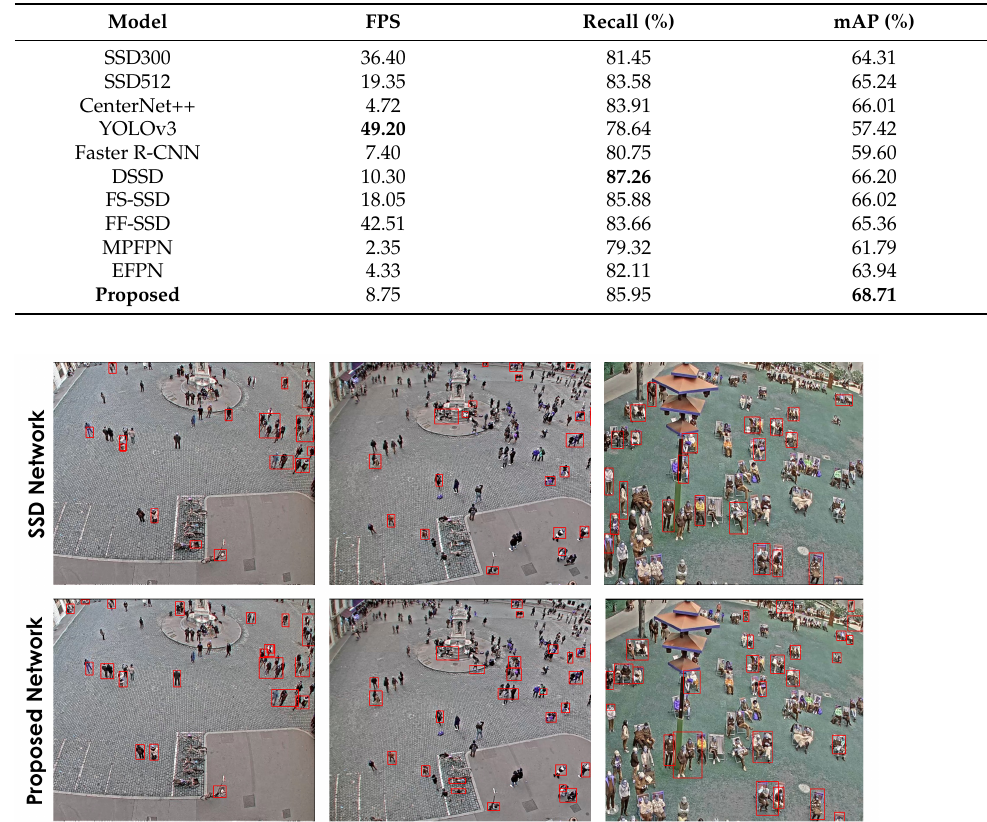
Figure 13. Comparison of small object detection of our proposed network ( bottom row ) with SSD network ( top row ) on a custom dataset acquired under MONICA project